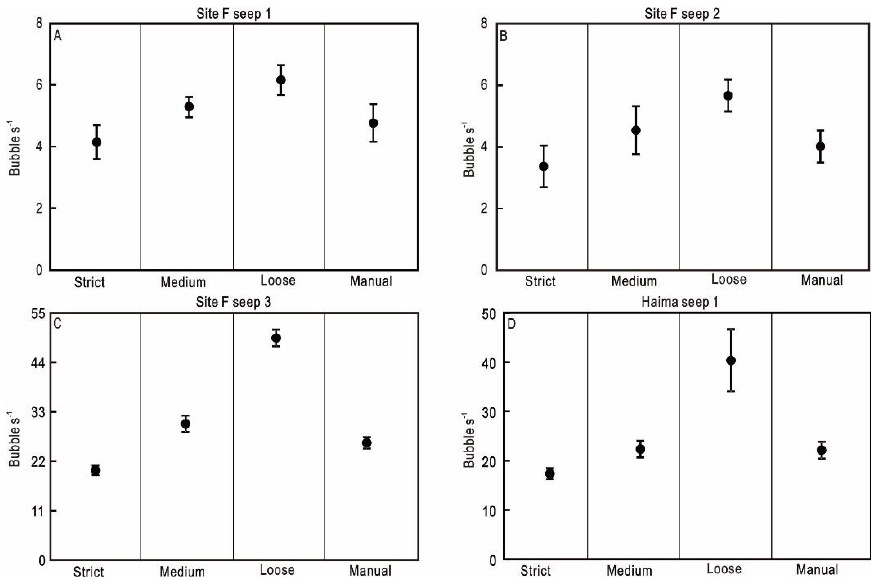
Figure 6. Average bubble release rates (with standard deviations) for each vent considering the different thresholds (strict, medium, and loose) and the manual cross-check count. ( A ) Site F seep 1; ( B ) Site F seep 2; ( C ) Site F seep 3; ( D ) Haima seep 1.